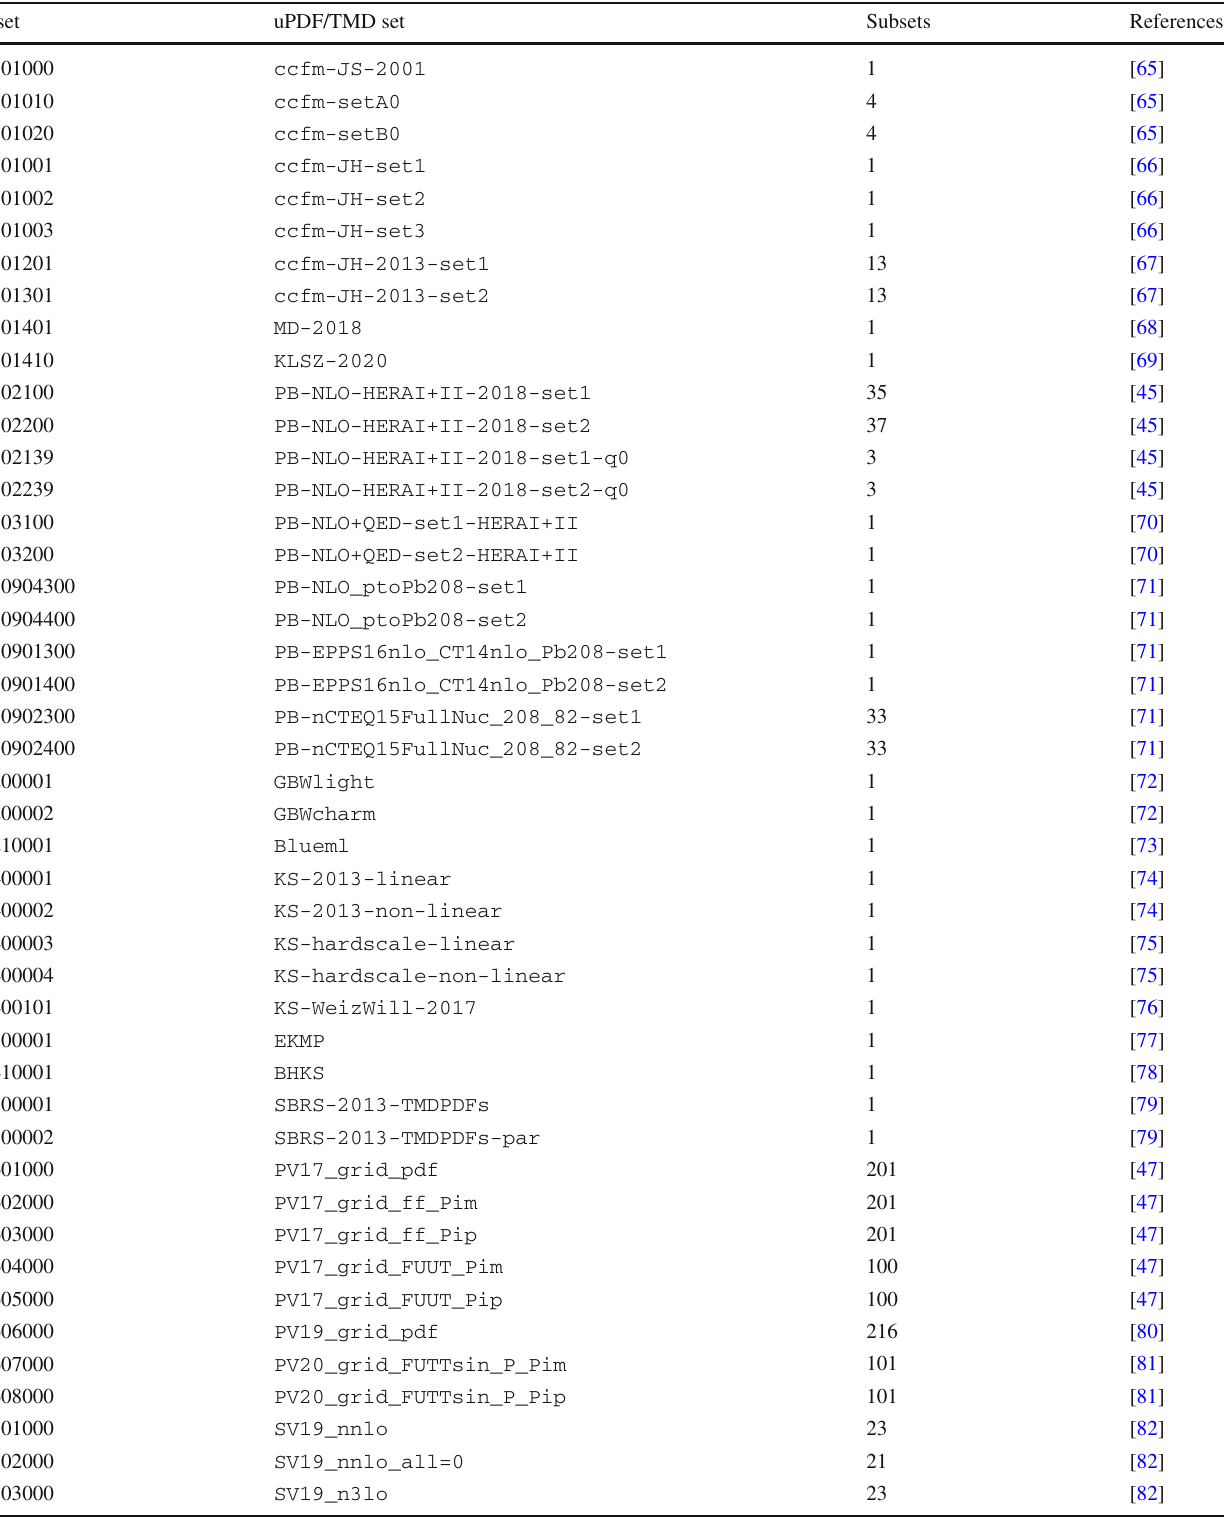
Table 1 Available uPDF/TMD parton sets in